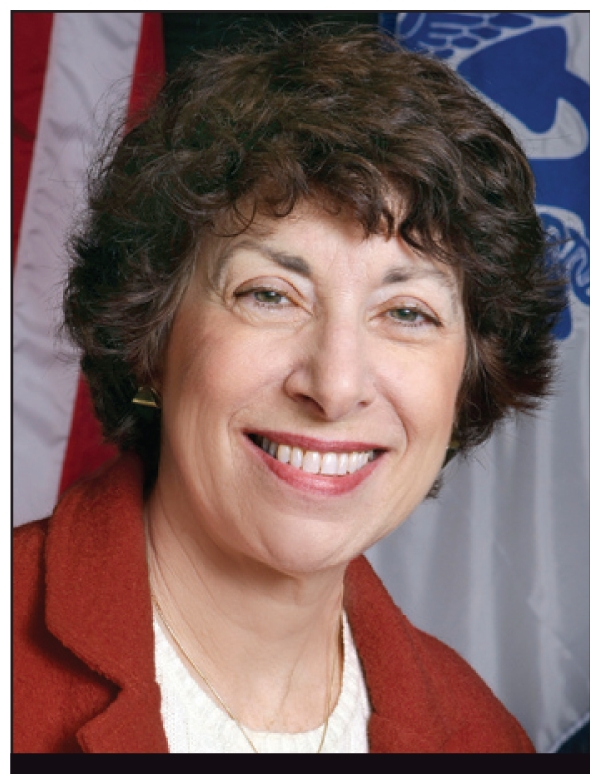
Linda S. Birnbaum